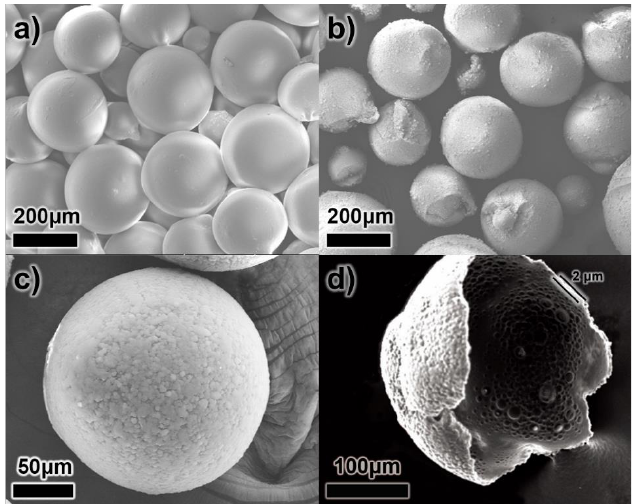
Figure 3. SEM images of microcapsules; ( a ) GB-SHMP microcapsules without UF resin coating (MCs), ( b , c ) with UF resin coating (DL-MCs) and ( d ) broken DL-MC.